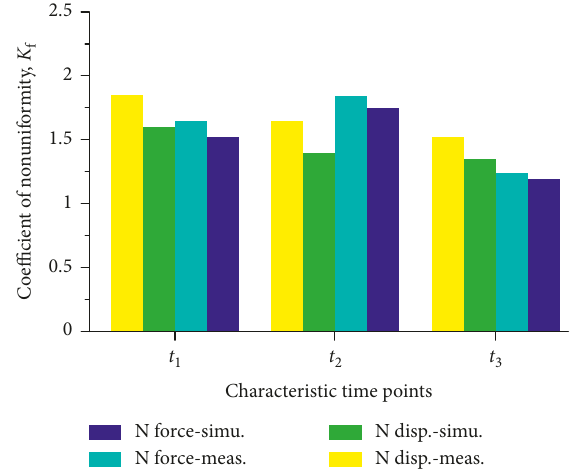
Figure 15: Comparison of calculated frost heave-induced de- formation and force and monitored